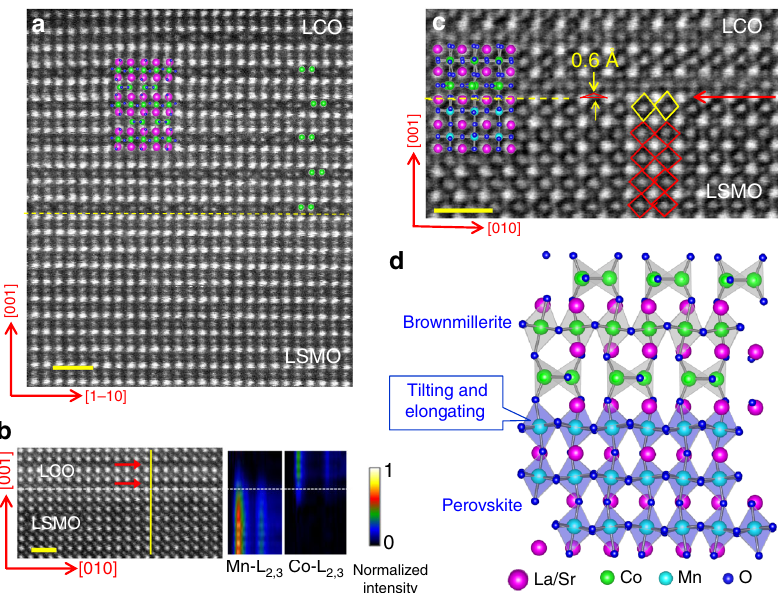
Fig. 1 Lattice images of the LCO/LSMO/LCO trilayers. a High-angle annular dark- fi eld (HAADF) image of the cross section of the LCO(5 nm)/LSMO(5 nm)/LCO(5 nm) heterostructure, recorded along the [110] zone. Brighter and fainter spots correspond to La/Sr and Mn/Co atomic columns, respectively. The lattice images with parallel dark stripes are LCO. The inset plot shows DFT calculated crystal structure of LaCoO 2.5 . Its agreement with experimental observation indicates that the LCO layer is brownmillerite structured. The yellow dashed line marks the LSMO – LCO interface. b HAADF image and the corresponding EELS spectrum images of the Mn-L 2,3 and Co-L 2,3 edges, recorded along the yellow line. The interface between the LCO and LSMO layers is marked by a dashed line. Red arrows denote dark stripes. It clearly shows that the Mn – O monolayer locates just below the interface. c Annular bright- fi eld (ABF) image of the cross section of the heterostructure, recorded along the [100] zone. The red triangle marks the misalignment of the interfacial La/Sr and O atoms. The yellow and red rhombuses denote the oxygen octahedra in interfacial and interior regions of LSMO, respectively. Inset plot: calculated crystal structure of LaCoO 2.5 . O-La/Sr misalignment can be clearly seen at interface. The red arrow marks the LSMO-LCO interface. d A sketch of the brownmillerite structure and the LCO/LSMO interface, obtained by the DFT calculations. Scale bar, 1